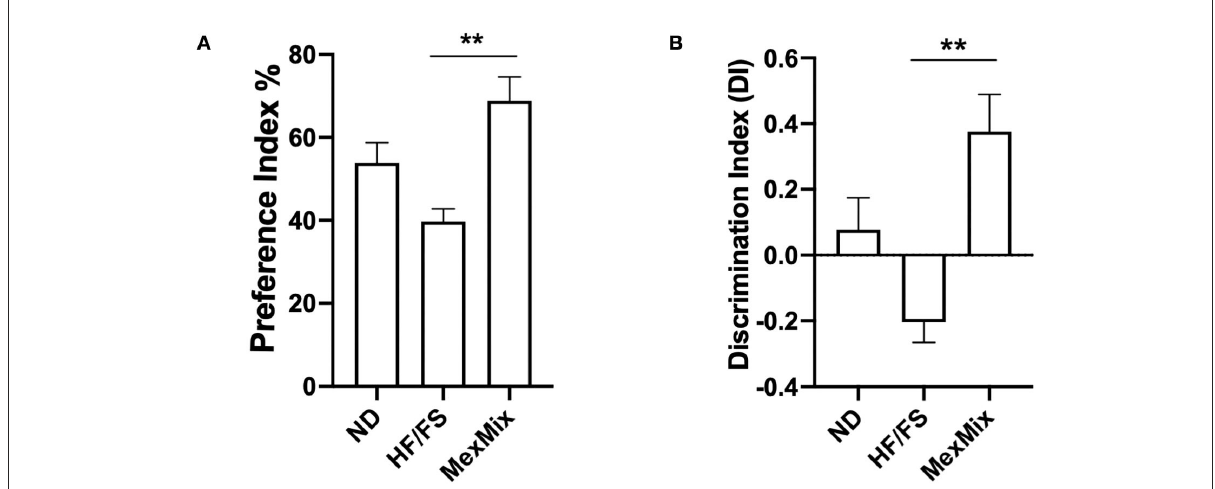
FIGURE7 Effect of MexMix diet on the novel object recognition (NOR) test. (A) Preference index. (B) Discrimination index. Data are expressed as mean ± SEM (** p <